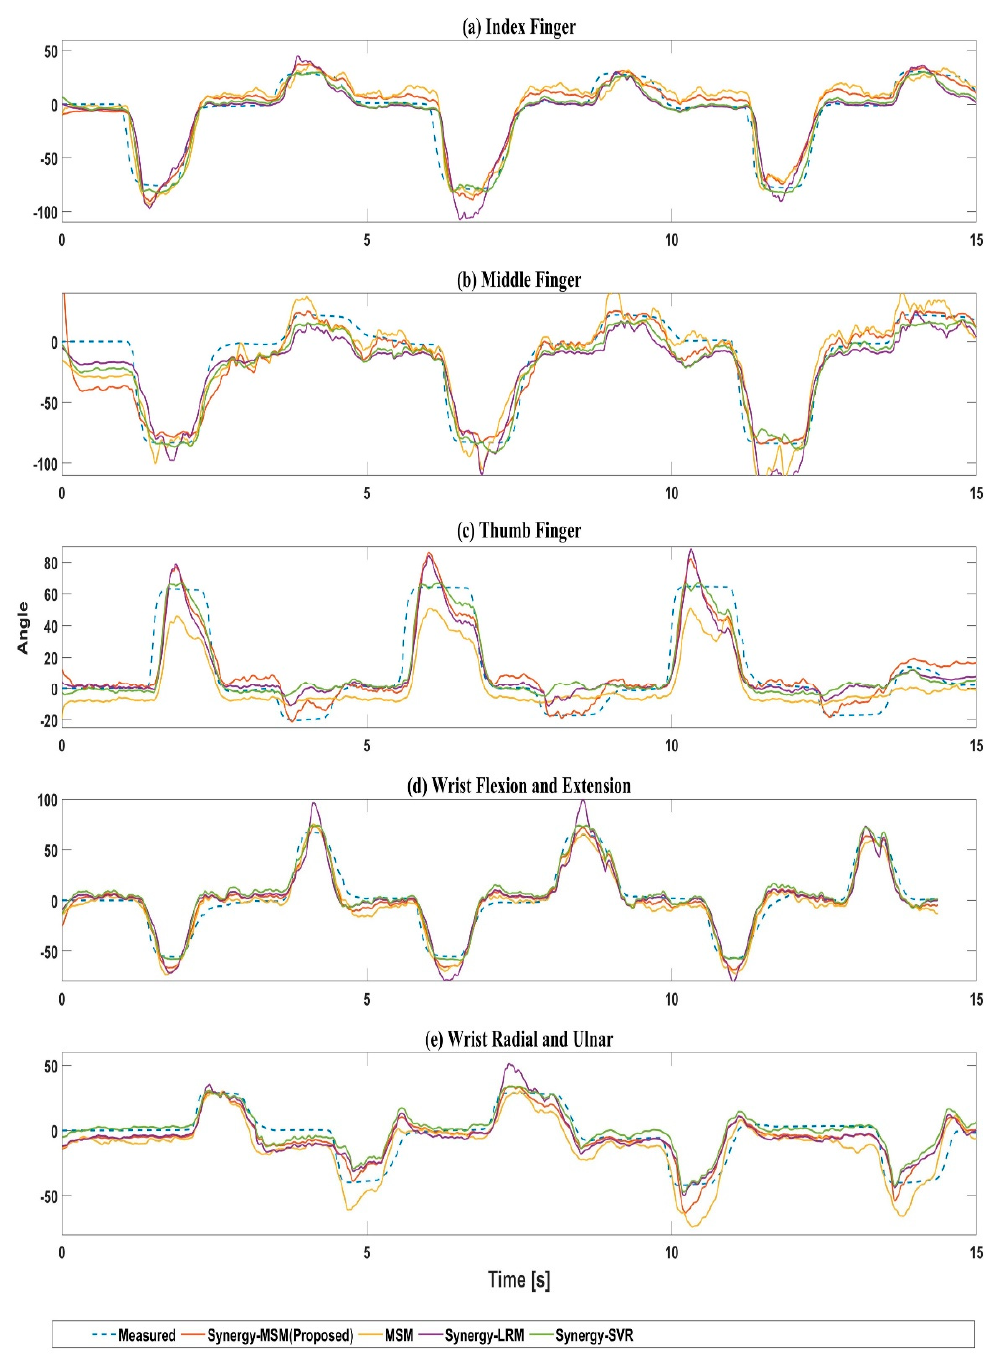
Figure 6. Test results for Subject 5: For ( a ) index finger, and ( b ) middle finger, and ( d ) flexion and extension motions of the wrist, the angle from 0 ◦ to − ◦ corresponds to the flexion motion and 0 ◦ to + ◦ corresponds to the extension motion. For ( c ) the thumb, 0 ◦ to + ◦ corresponds to the flexion motion, and 0 ◦ to − ◦ corresponds to the extension motion. For ( e ) radial and ulnar deviations of the wrist, 0 ◦ to + ◦ corresponds to the radial deviation, 0 ◦ to − ◦ corresponds to the ulnar deviation. The blue dashed line indicates the measurement angle of Perception Neuron. The red line is the estimated value from the Synergy-MSM, the yellow line is the estimated value from the MSM, the purple line is the estimated value from Synergy-LMR, and the green line is the estimated value from SVR.